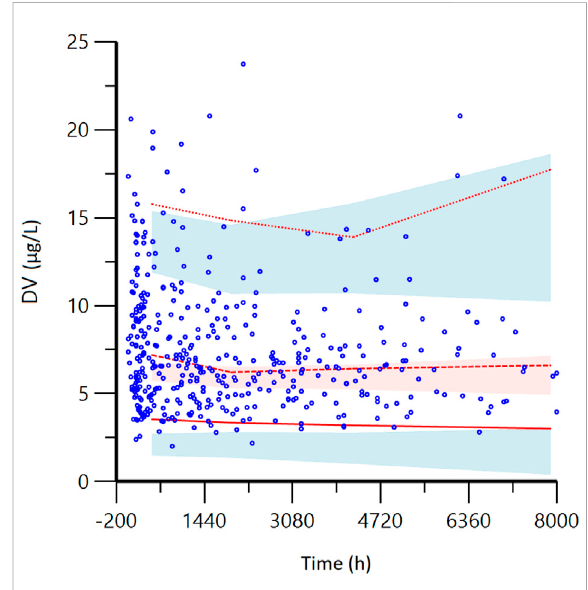
FIGURE 3 Visual predictive check (VPC) from the fi nal model. DV: observed concentrations; The red lines from bottom to top represent the 5th, 50th, and 95th percentiles of the observed concentrations; Blue shaded regions are 95% con fi dence intervals for predicted 5th and 95th percentiles. Red shaded regions are 95% con fi dence intervals for the predicted 50th percentile. As shown in the fi gure, most of the red lines representing the measured concentration positioned are within the predicted shadow range, indicating that the model has good prediction